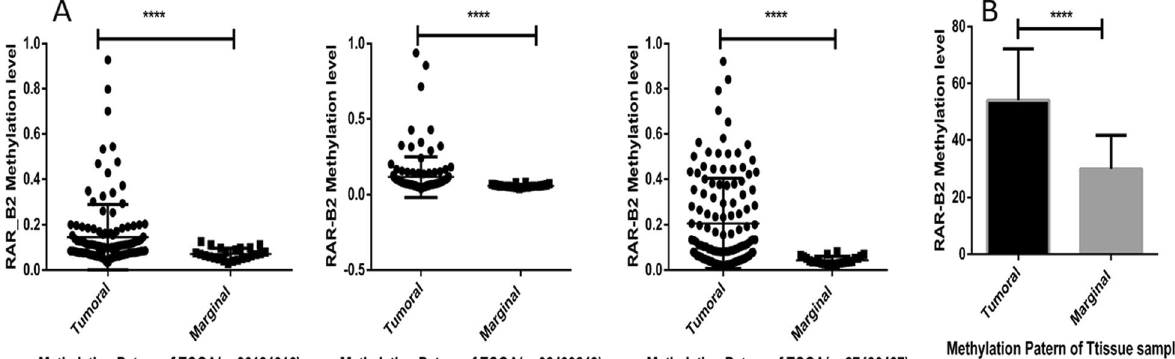
Fig. 2 A RAR-B2 methylation pattern of TCGA datasets. Comparison of RAR-B2 overall methylation levels between NSCLC and normal samples using TCGASTAD methylation cohort. RAR-B2 shows significantly hypermethylated in NSCLC tumors; **** P < 0.0001. B RAR-B2 methylation pattern of tissue samples using q-MSP. The obtained results showed that these gene is significantly hypermethylated in NSCLC tumors in comparison with normal adjacent tissues; *** P <